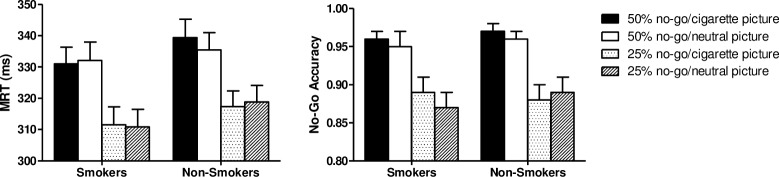
Left: Mean reaction time (+ SEM) of smokers and non-smokers on go trials of the 600-ms stimulus presentation time blocks. Values are presented separately for each no-go stimulus percentage and stimulus type condition. The only significant effect was faster overall responding on the 25% no-go trials condition than the 50% condition (p < 0.001). Right: Mean (+ SEM) proportion of trials of the 600-ms stimulus presentation time blocks on which smokers and non-smokers correctly omitted responding to the no-go stimulus, separately for each no-go stimulus percentage and stimulus type condition. The only significant effect was a higher accuracy rate for the 50% no-go trials condition than the 25% condition (p < 0.001).